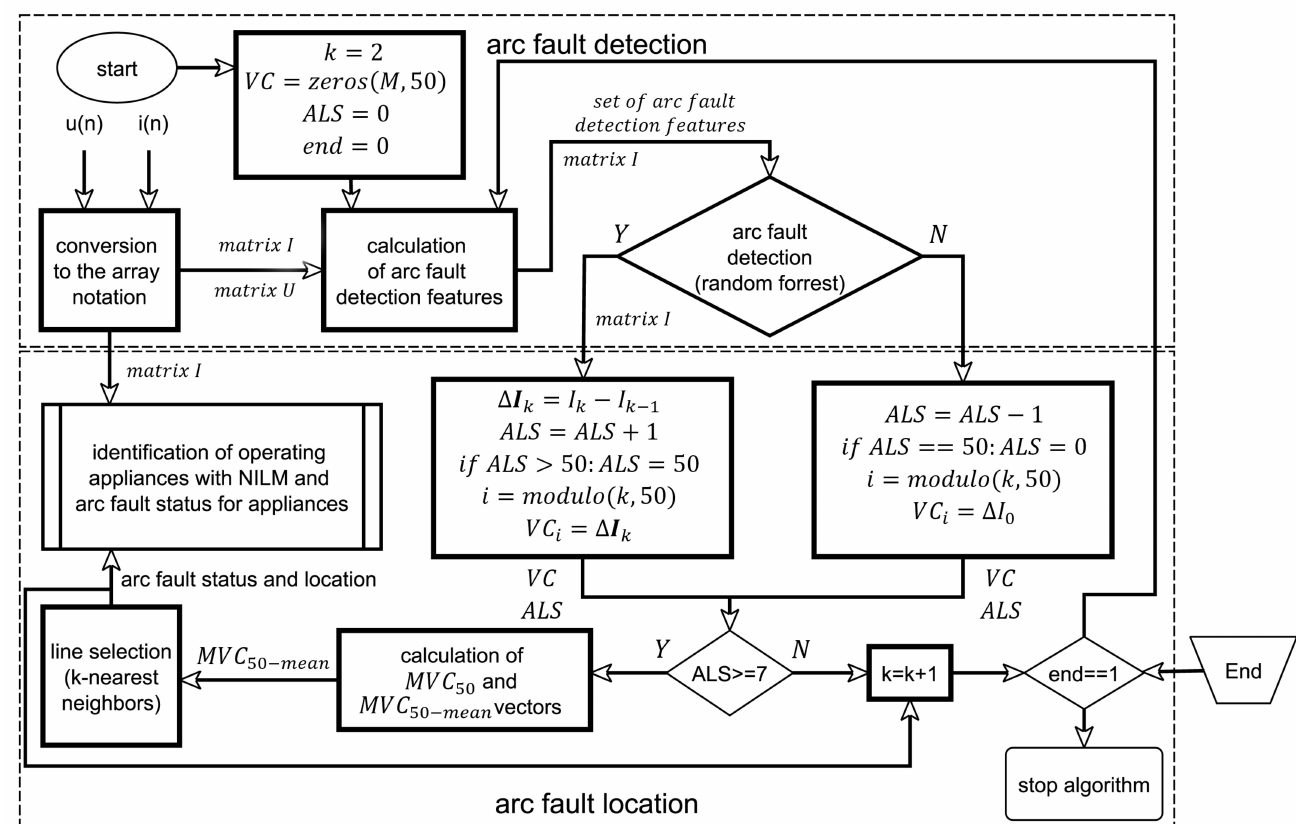
Figure 2. Arc fault detection and location